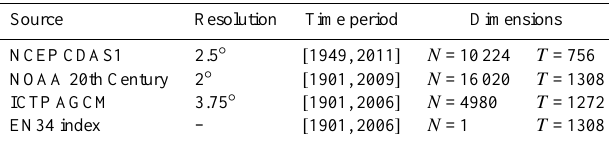
Table 1. Characteristics of data. N : number of grid points, T : num- ber of months.